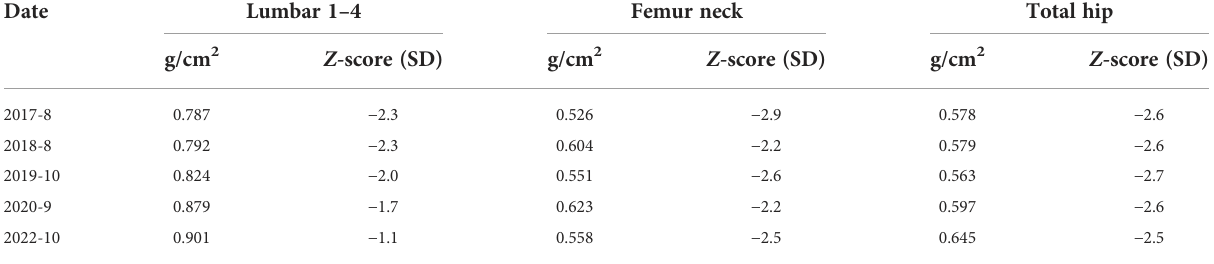
TABLE 1 The change in bone mineral density.